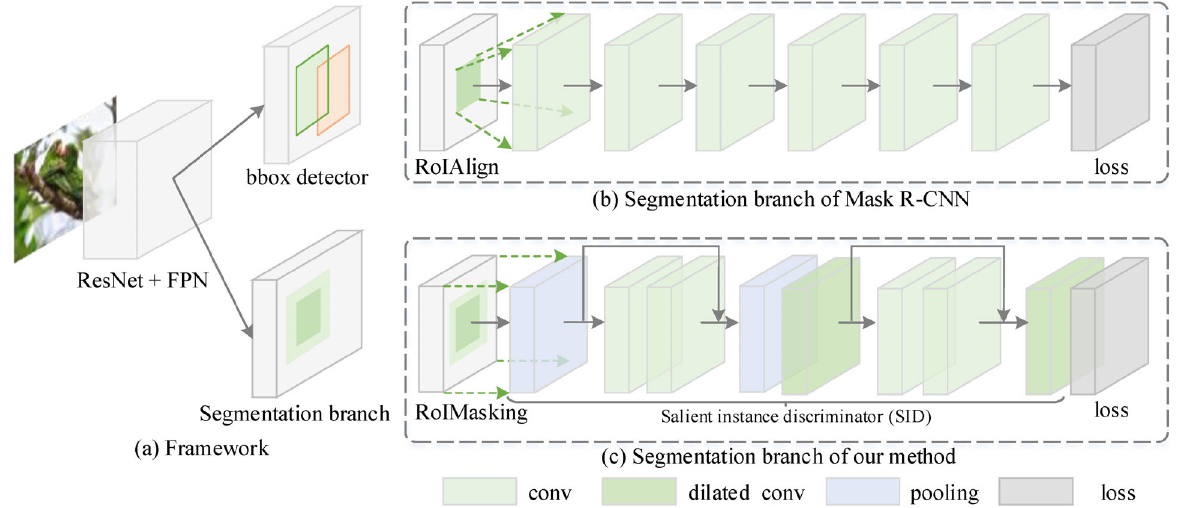
Fig. 2 Pipeline of the proposed method. (a) Simplified framework. For simplicity, we omit the backbone used. See Ref. [32] for more information. (b) Segmentation branch proposed in Mask R-CNN [31], comprising a stack of consecutive convolutional layers. (c) Our proposed segmentation branch which further enlarges the size of the receptive field but has the same number parameters as in